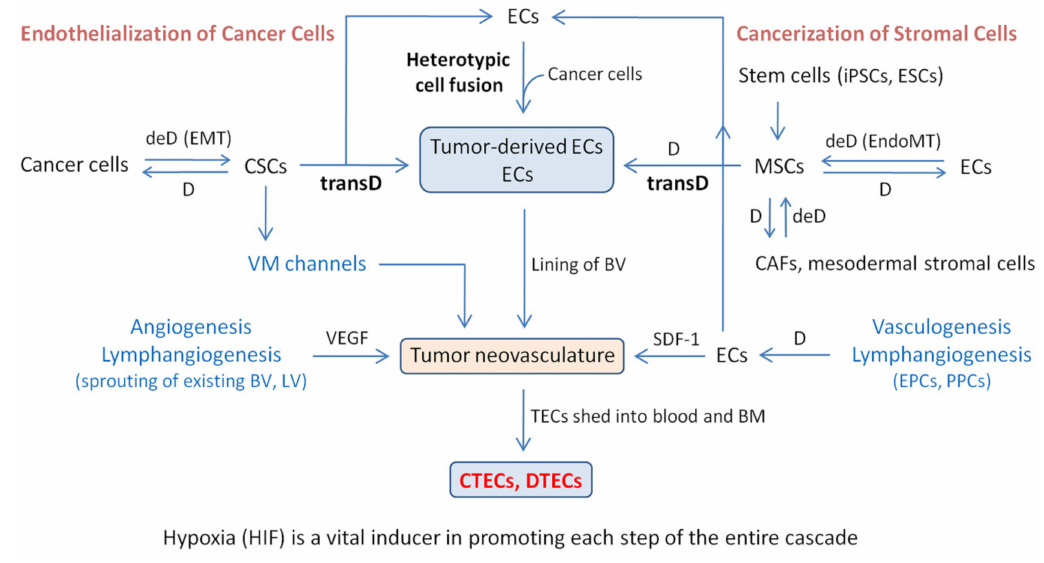
Figure 3. Hypoxia-induced tumor neovascularization cascade generates CTECs in cancer patients. Tumor neovascularization in carcinoma patients is contributed by endothelium-dependent angiogenesis, vasculogenesis, lymphangiogenesis, and endothelium-independent cancer cell-derived VM channels. The lining of blood vessels (BVs) in tumor vasculature is constituted primarily by CD31 + tumor-derived ECs. Aneuploid TECs, the endothelialized cancer cells in essence, are derived from both cancerization of stromal cells (such as ECs) and endothelialization of malignant tumor cells, of which the latter consists of the heterotypic cell fusion of cancer cells with ECs and the transdi ff erentiation (transD) of carcinoma cells via CSCs. In the tumor microenvironment (TME), in addition to participating in channel formation by vasculogenic mimicry (VM), undi ff erentiated tumorigenic CSCs di ff erentiate (D) into cancer cells, mesenchymal CSCs through EMT. Cancerization-relevant MSCs are derived from induced